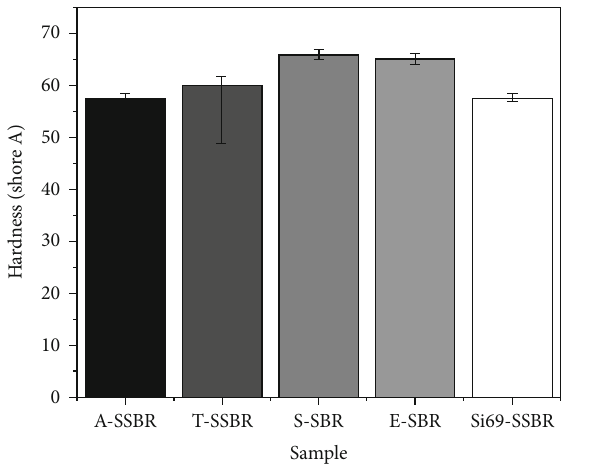
Figure 7: The hardness test (Shore A) results of the samples.